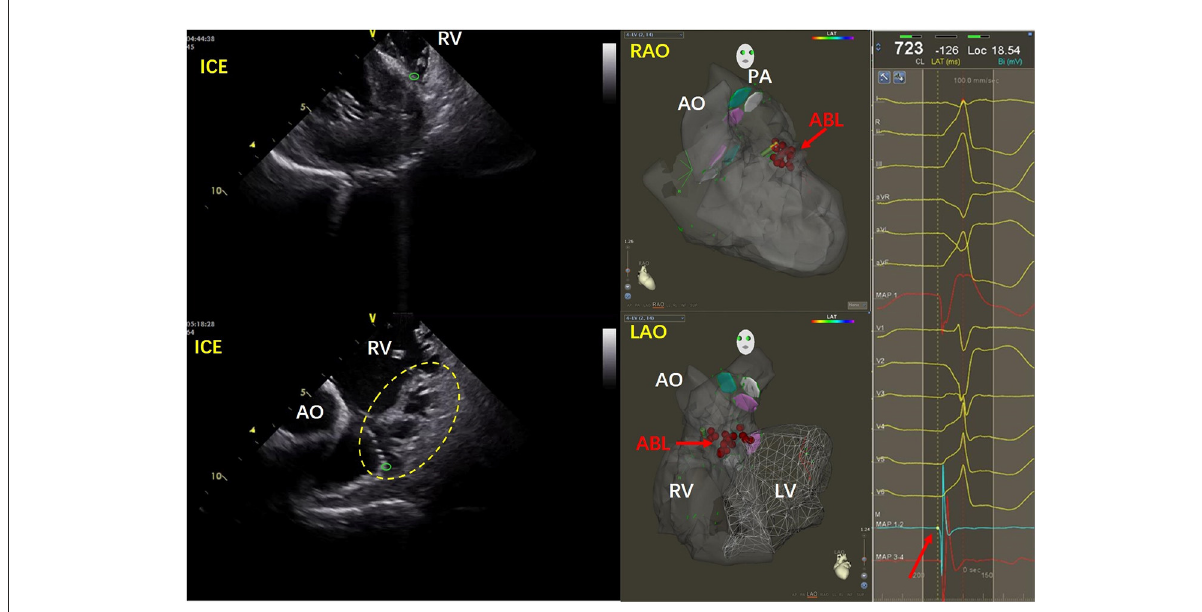
FIGURE1 Images for a patient with PVCs that originated from the inferoanterior septum in the inferior RVOT. In the ICE image on the left , the tip of the ablation catheter is indicated by the green circle. Abundant trabeculae can be seen in the yellow dotted line area. The tip of the ablation catheter is visible embedded at the intersection of the muscle trabeculae at their junction with the smooth conus of the pulmonary artery. The red arrow in the middle three-dimensional image shows the ablation target. On the right side of the figure, the red arrow indicates the early potential at the ablation site. ABL, ablation; AO, aorta; ICE, intracardiac echocardiography; LAO, left anterior oblique; LV, left ventricle; PA, pulmonary artery; RAO, right anterior oblique; RV, right ventricle.